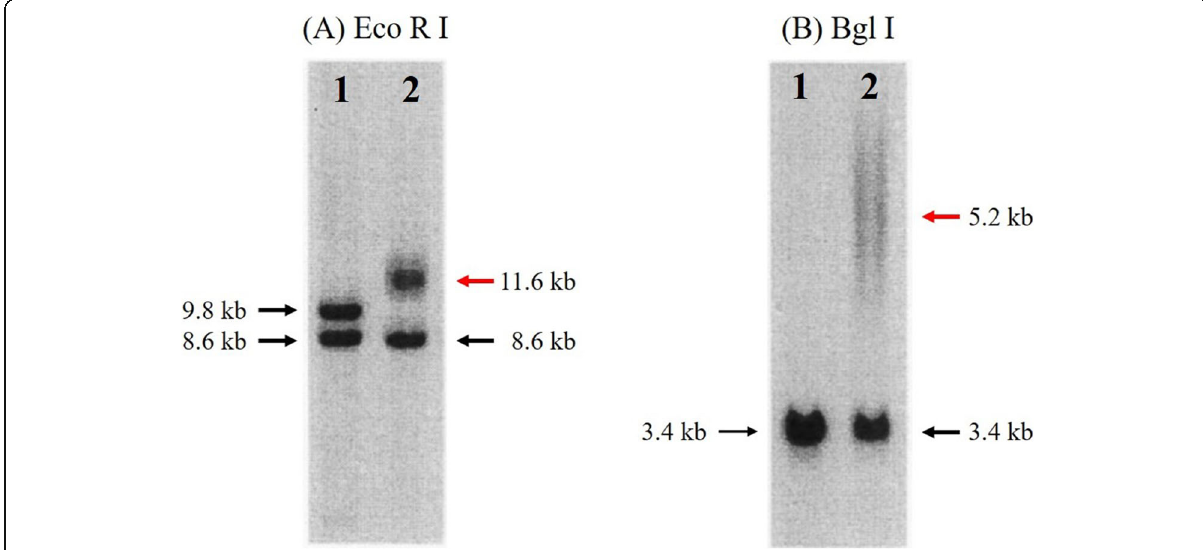
Fig. 1 Southern blot analysis of the patient ’ s genomic DNA samples. Southern blots of ( a ) EcoRI- and ( b ) BglI-digested genomic DNA from a normal subject (control, lane 1) and from the myotonic dystrophy type 1 patient (case, lane 2). Expanded CTG repeat (red arrow) at 11.6 kb in DMPK gene was respectively detected in the affected